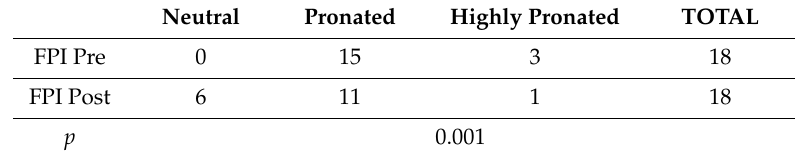
Table 3. Changes in foot posture index (FPI) group after the 9 weeks of the physical